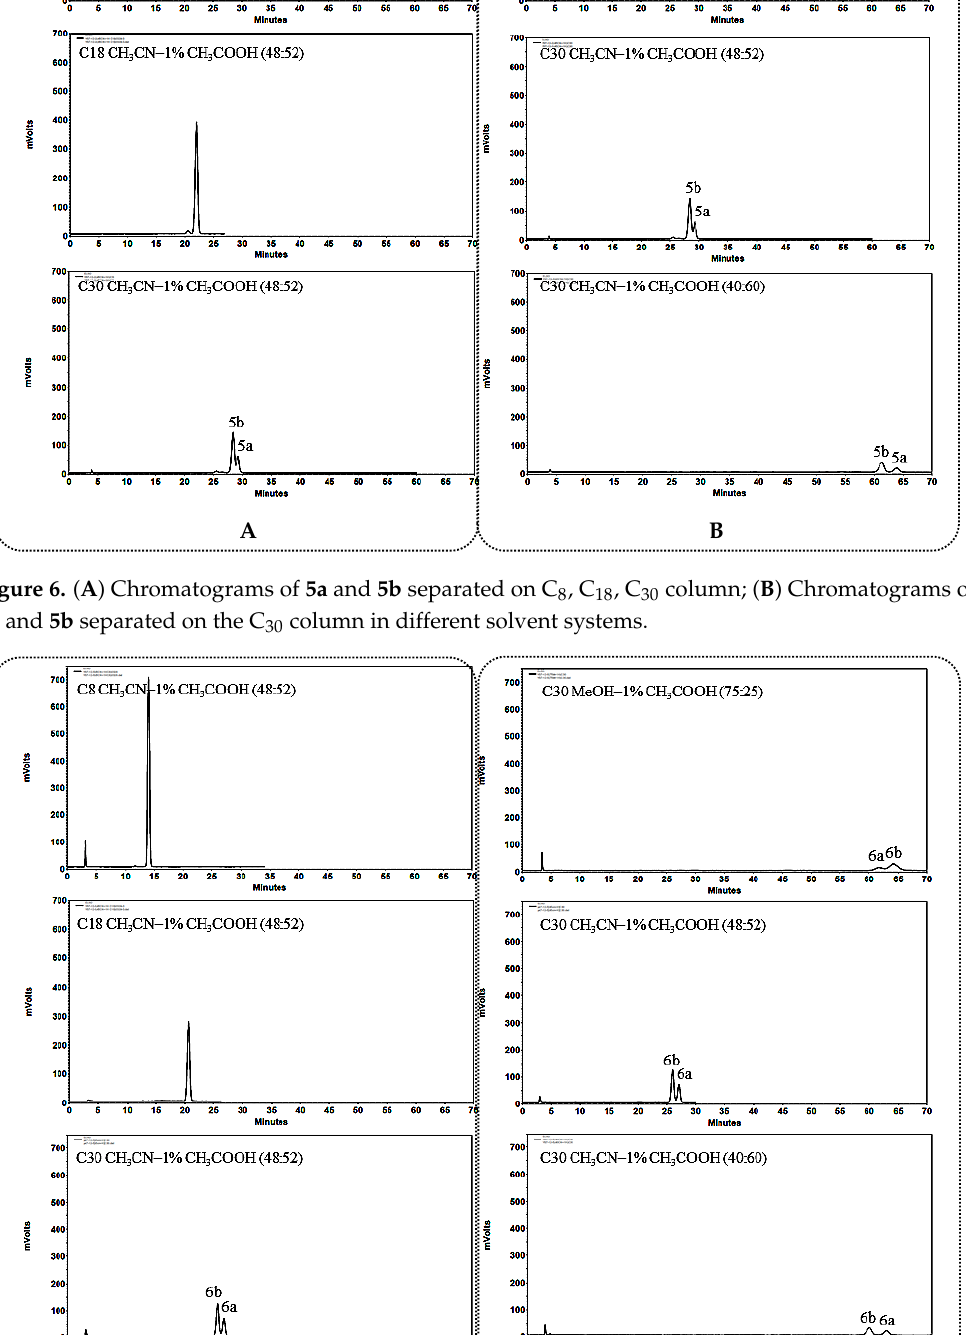
Figure 7. ( A ) Chromatograms of 6a and 6b separated on C 8 , C 18 , C 30 column; ( B ) Chromatograms of 6a and 6b separated on the C 30 column in different solvent systems.